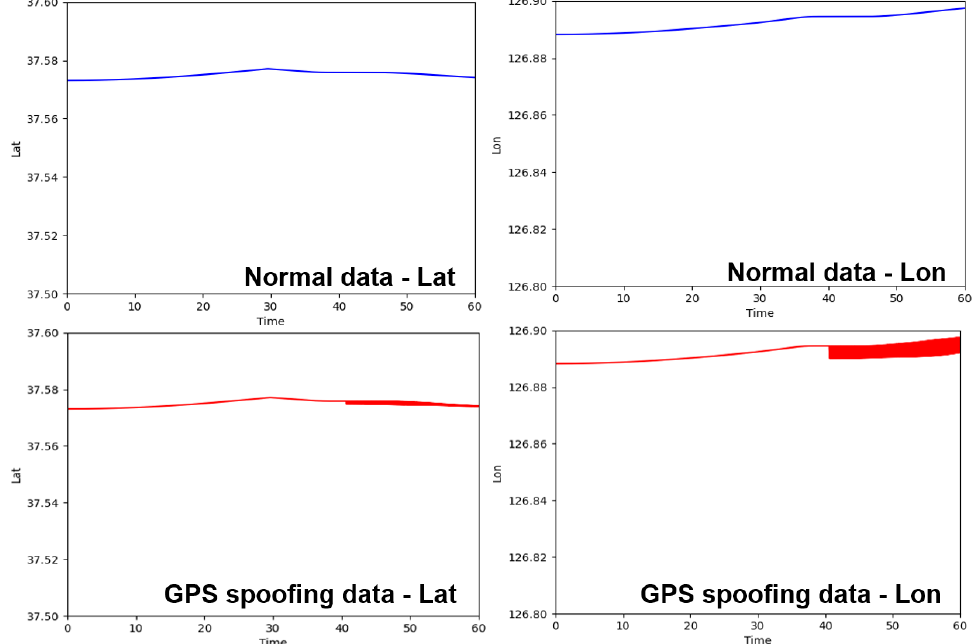
Figure 12. The graphs are the results of collecting and analyzing V2X messages generated in the simulation network after performing a GPS spoofing attack. With the occurrence time of V2X messages on the x-axis and the lat and lon values on the y-axis, the graphs show the changes when the GPS spoofing attack occurred. When driving normally, the values changed smoothly according to the driving route, but when the GPS spoofing occurred, the GPS value moved